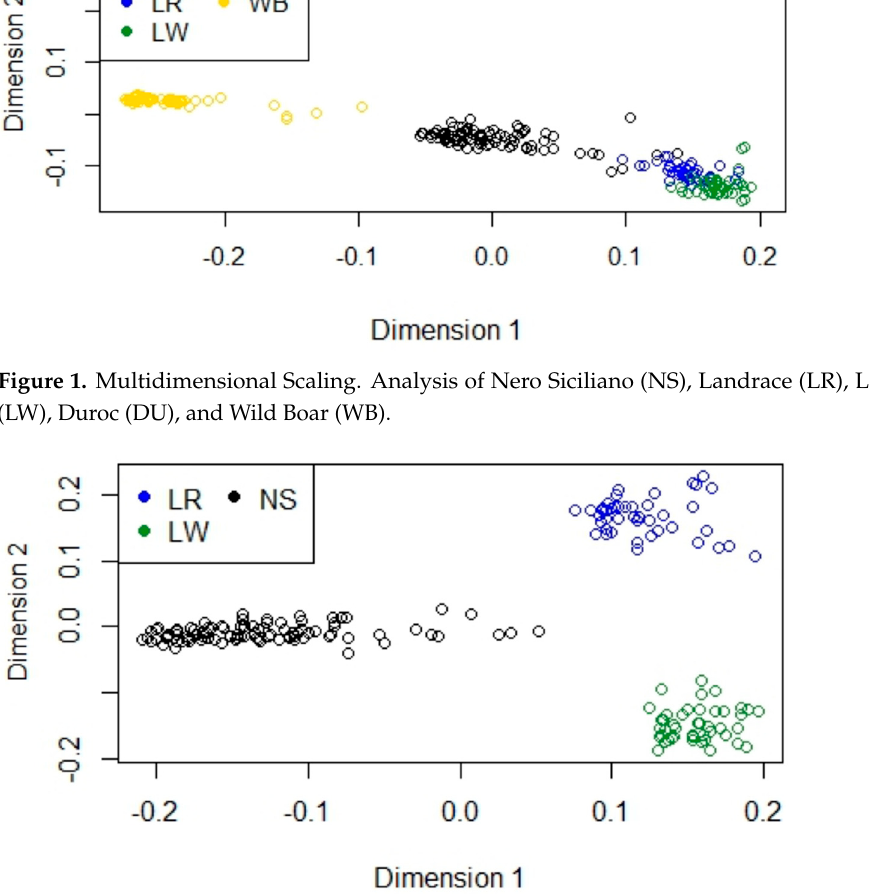
Figure 2. Multidimensional Scaling. Analysis of Nero Siciliano (NS), Landrace (LR), and Large White (LW).